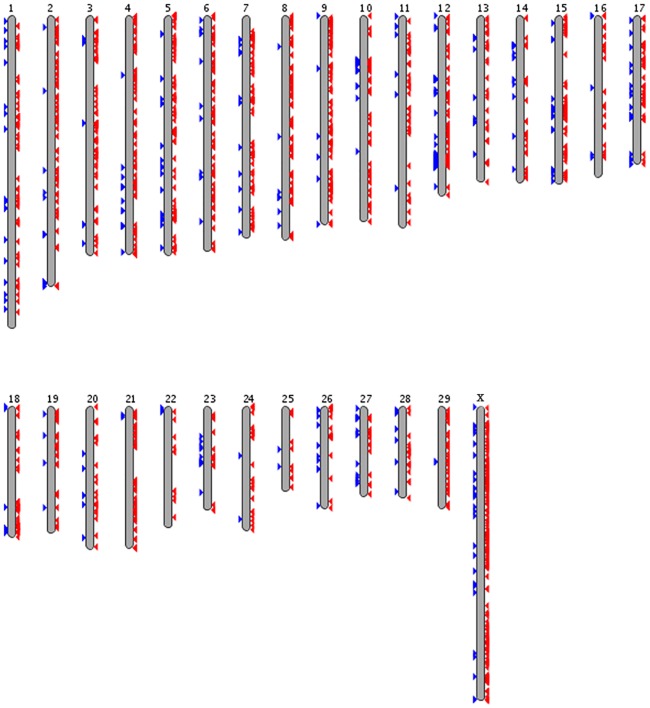
Schematic diagram of copy number variations (CNVs) regions in cattle genome.Blue arrowheads located on the chromosome ideograms represent copy number gains in Nanyang against with Qinchuan; while the red arrowheads represent copy number gains in Qinchuan against with Nanyang (Nanyang CNV losses). Note that several CNVs may combine and display as a single arrowhead due to their proximity in the genome.